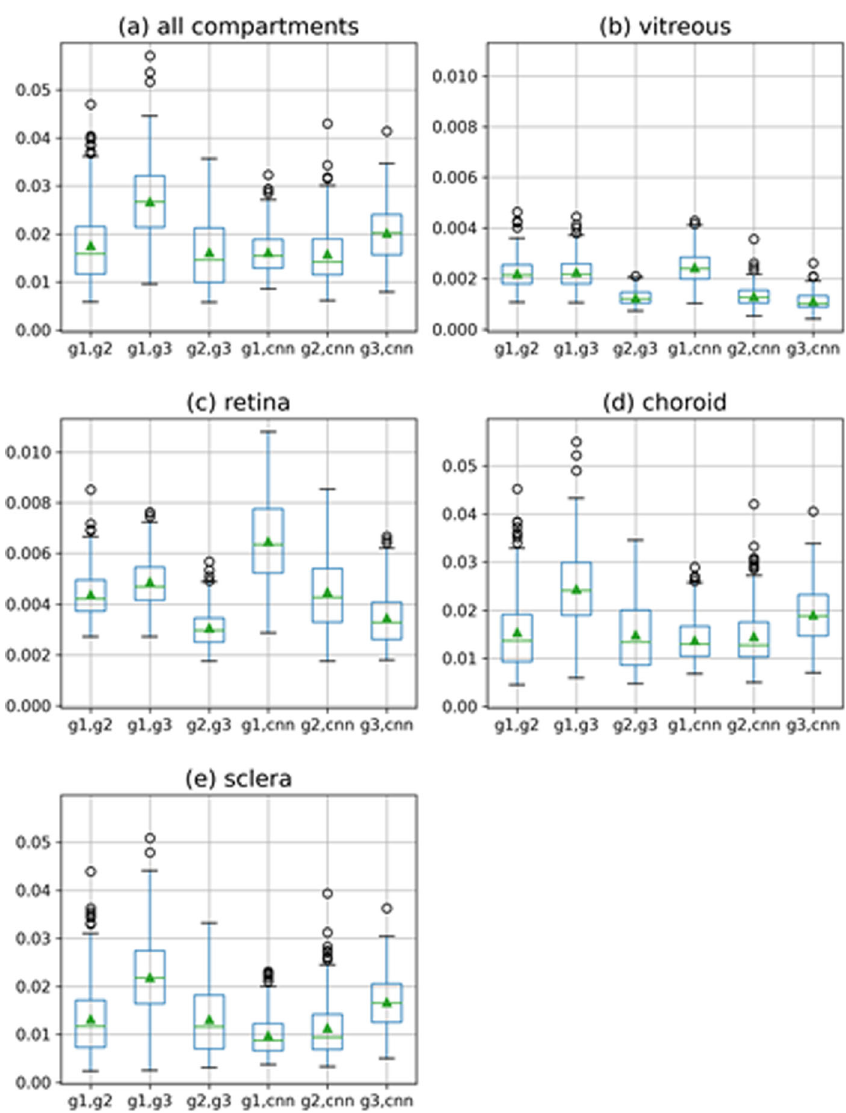
Fig. 3 Boxplots of Hamming distances as the percentage of pixels that were labeled differently. The distribution of variability is shown between segmentations of the human graders (g1 – g3) and the CNN predictions. Boxplots show pairwise comparisons of g1 with g2, g1 with g3, g2 with g3, g1 with CNN, g2 with CNN, and g3 with CNN. a shows the variability over all compartments, b for the vitreous compartment, c for the retina compartment, d for the choroid compartment, and e for the sclera compartment. Rectangular boxes in boxplots represent interquartile ranges (IQR) and extend from quartile Q1 to quartile Q3 with green lines and green triangles indicating median (Q2) and mean, respectively. Upper whiskers extend to the last datum which is less than Q3 + 1.5 × IQR. Lower whiskers extend to the fi rst datum which is greater than Q1 − 1.5 × IQR. Data beyond whiskers are considered as outliers and are plotted as individual circles. Note: the retina and vitreous axes are zoomed in to demonstrate the compartment-speci fi c variability. Overall and for each compartment but the retina, the total inter-grader difference was larger than the difference between human graders and the